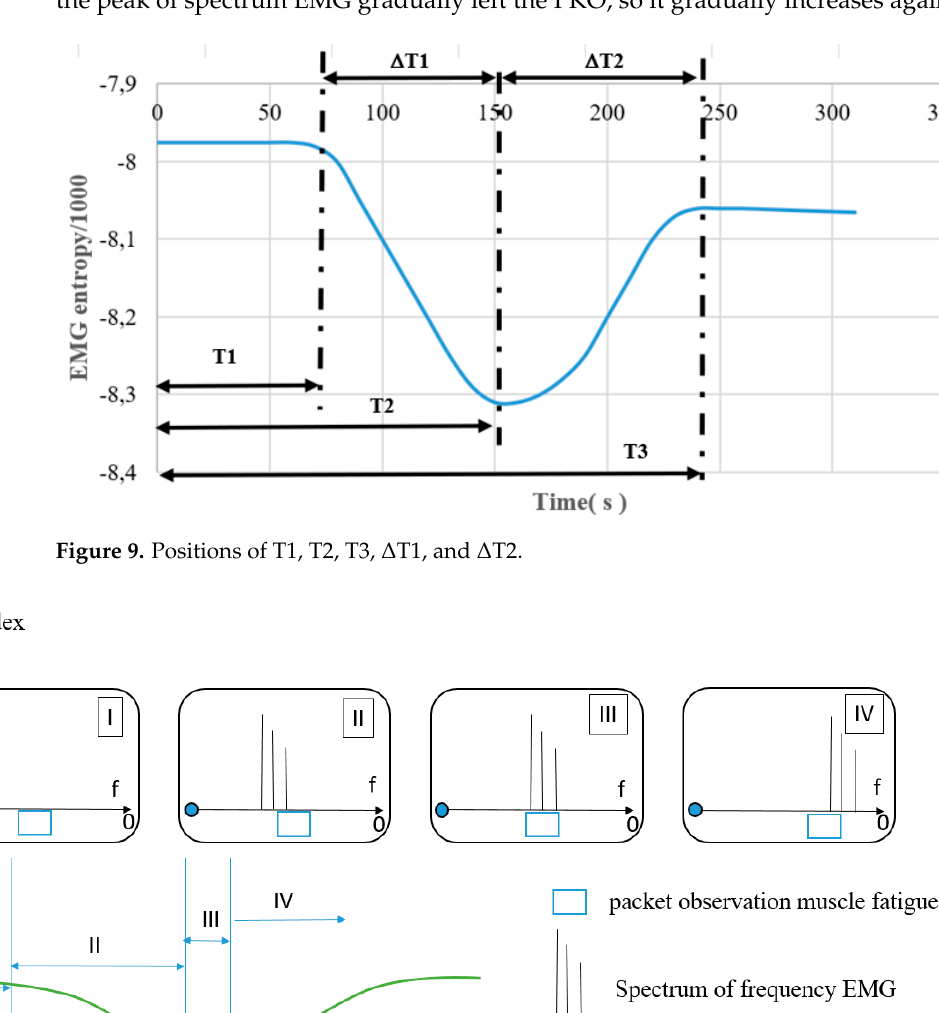
Figure 9. Positions of T1, T2, T3, ∆ T1, and ∆ T2.